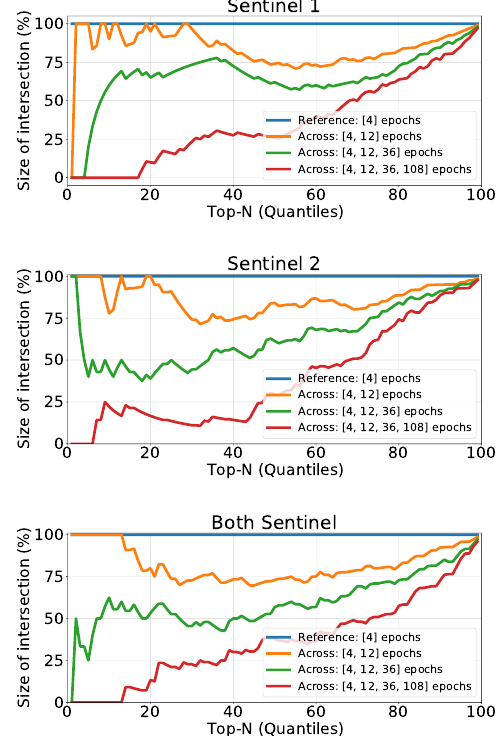
Figure 11. Negative persistence for Sentinel-1, Sentinel-2 and when using both